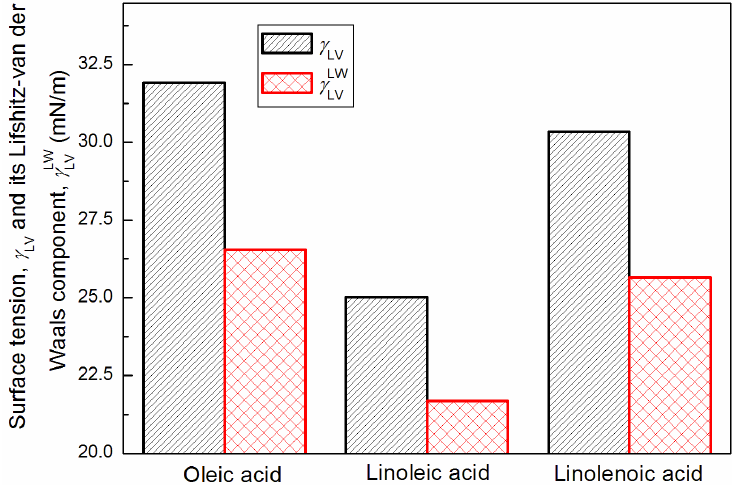
Figure 1. The values of the surface tension ( γ LV ) and the Lifshitz-van der Waals component of this tension. ( γ LW ) for oleic, linoleic, and linolenic acids.